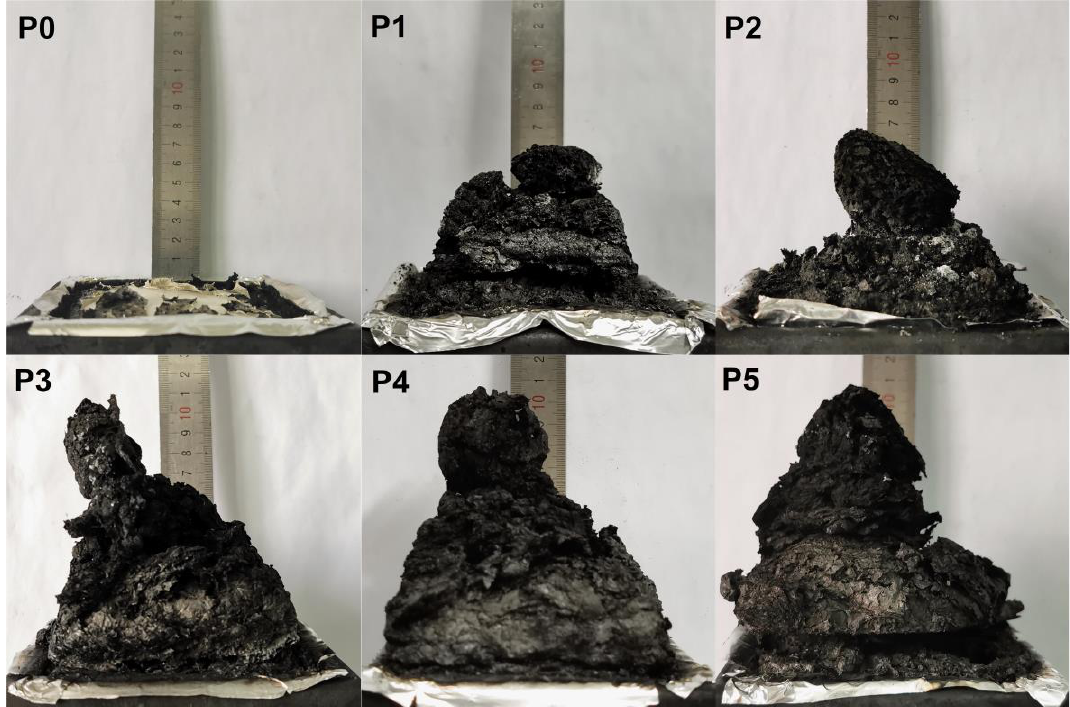
Figure 10. Digital photo of carbon layer after cone calorimetry test.